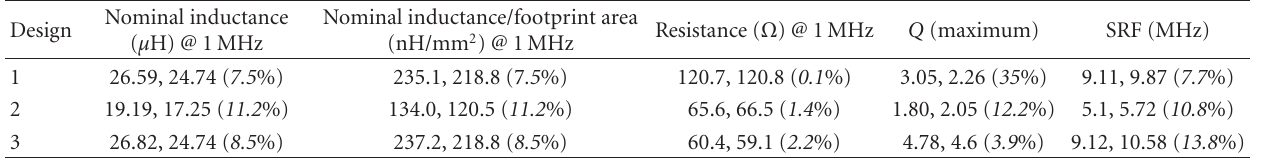
Table 2: Performance metrics for geometry variations (theory, experiment ( error